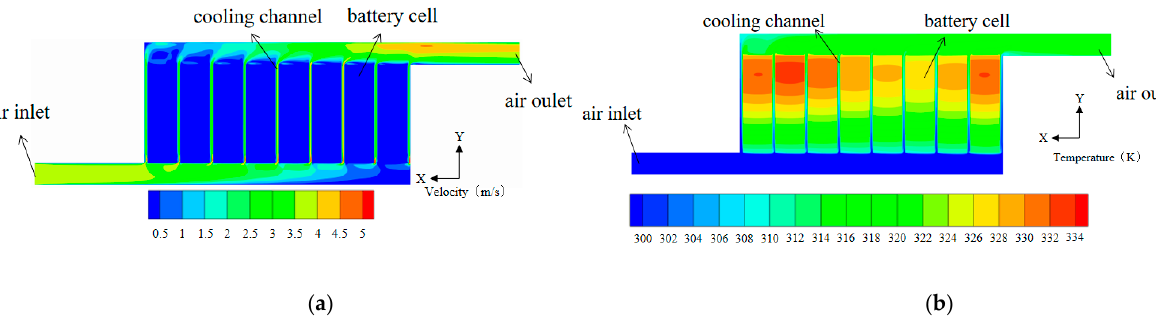
Figure 8. Flow and temperature fields of case2; ( a ) velocity contour of case2; ( b ) temperature contour of case2.